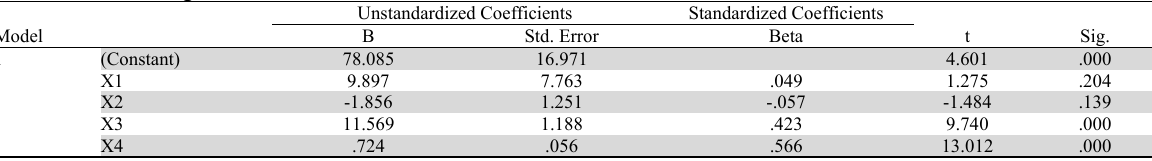
The results of the regression estimate